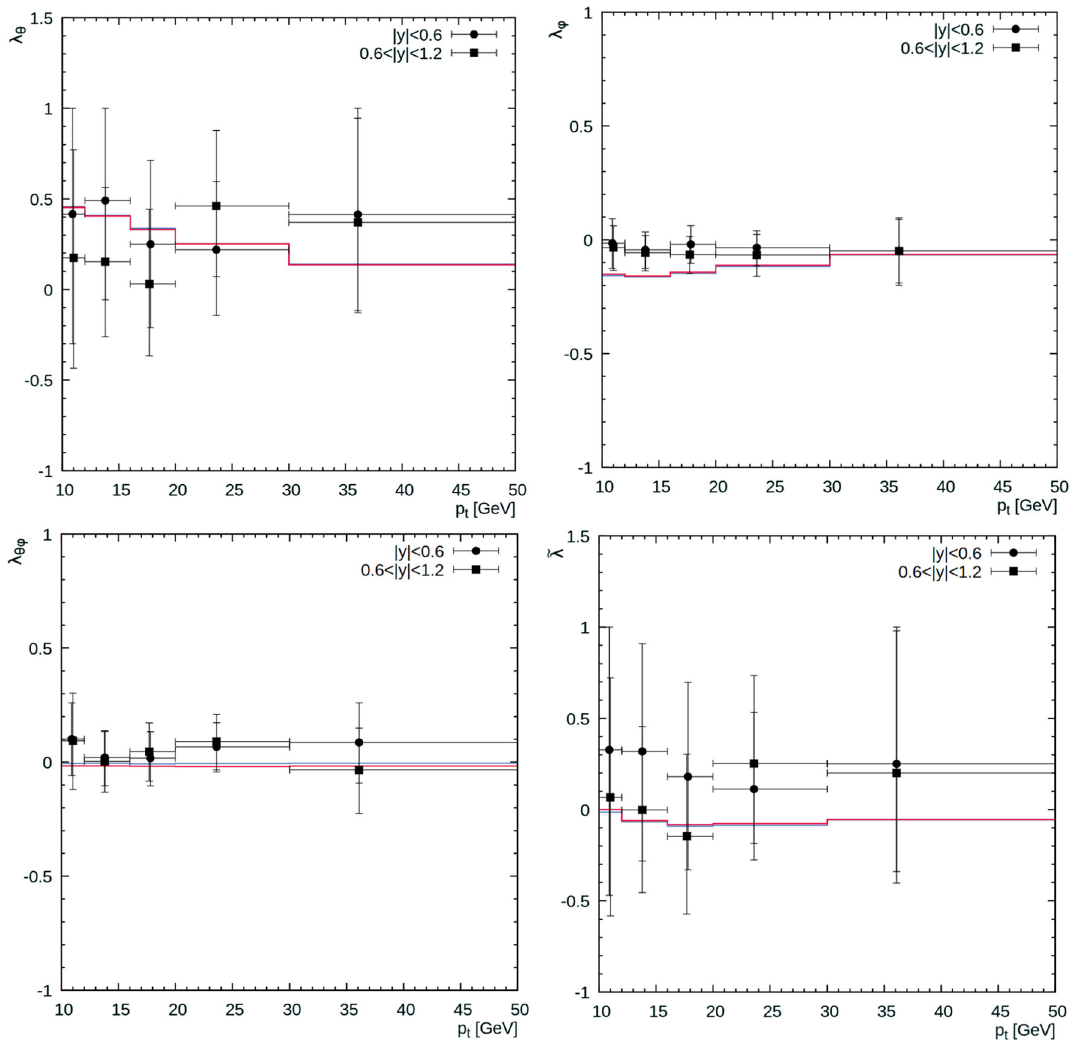
Fig. 8 The polarization parameters λ θ , λ φ , λ θφ and ˜ λ of ϒ( 2 S ) mesons calculated in the perpendicular helicity frame as function of its transverse √ s = 7 TeV. Notation of all histograms is the same as in Fig. 6. The experimental data are from CMS momentum at